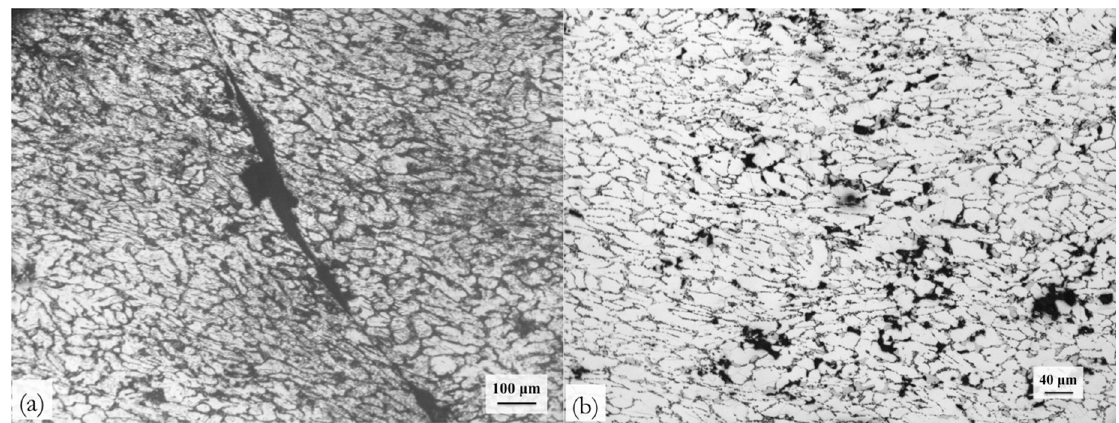
Figure 10. Optical microstructures of the ABaX633 alloy deformed corresponding to instability regimes at ( a ) lower temperatures (300 °C/10 s − 1 ), and ( b ) higher temperatures (500 °C/ 10 s − 1 ) in the processing map. The compression axis is vertical.